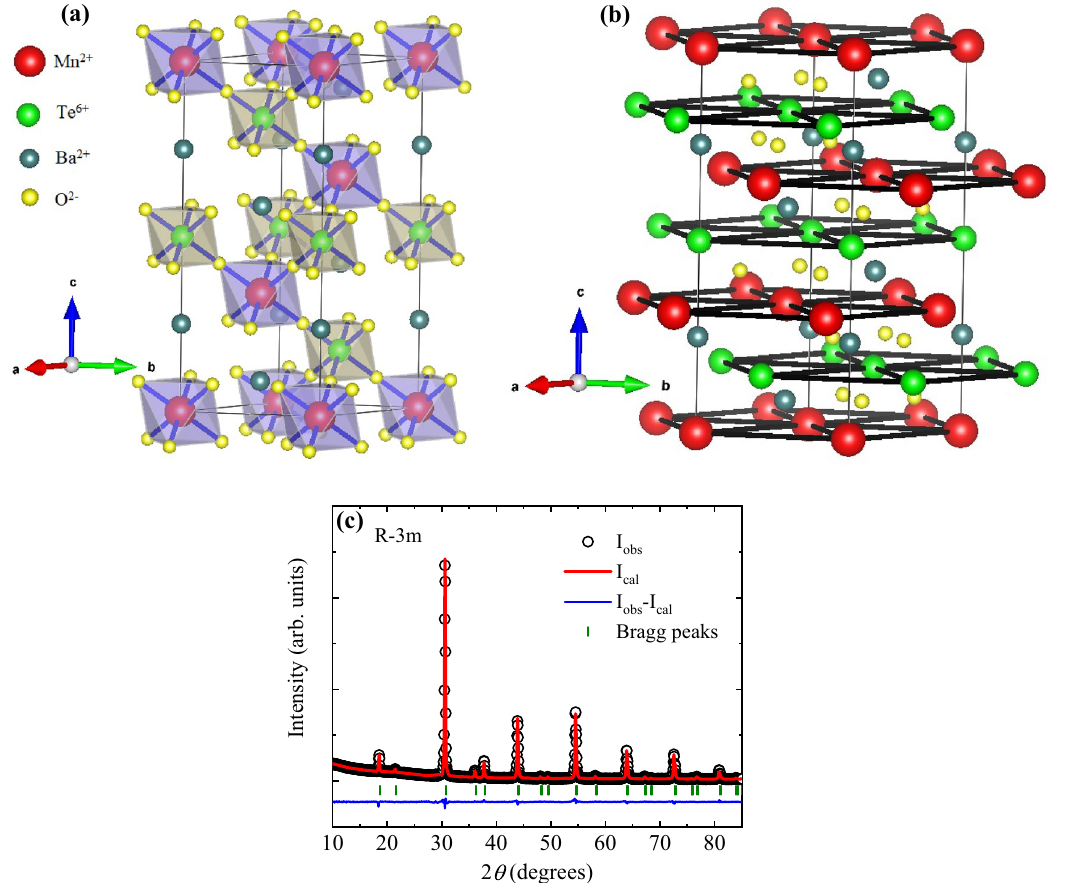
Figure 1. ( a ) The arrangement of MnO 6 (purple) and TeO 6 (dark yellow) octahedra in the unit cell of BMTO. 2 6 ( b ) Schematic of consecutive triangular layers of Mn + ions (red) separated by triangular layer of Te + ions (green) along c axis. The VESTA software 42 was used for visualization of the crystal structure. ( c ) Rietveld refinement profile of X-ray diffraction data with the solid line ( I cal ) through the experimental points ( I obs ) calculated for trigonal crystal structure of BMTO. The olive vertical bars indicate the position of the Bragg reflections and the residual data are denoted by the blue solid line.